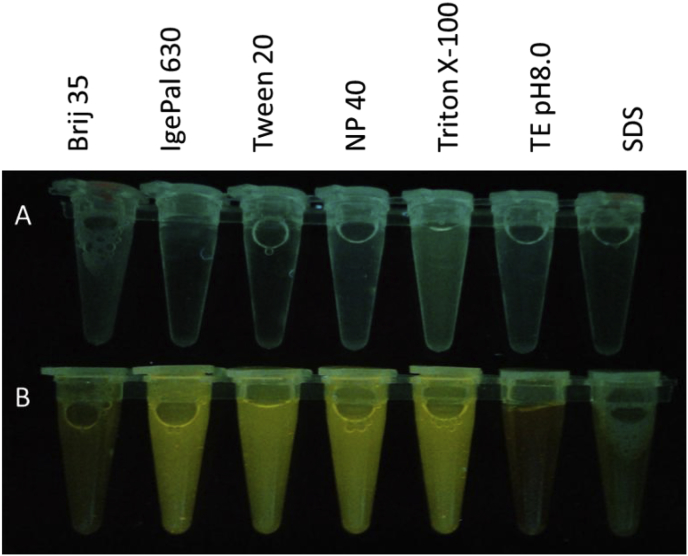
Fluorescence of SYBR® Green I emulsified with various surfactants. A) 1% surfactants in 1 kDa-filtered TE pH 8.0; B) with 50x SYBR® Green I added. (For interpretation of the references to colour in this figure legend, the reader is referred to the Web version of this article.)